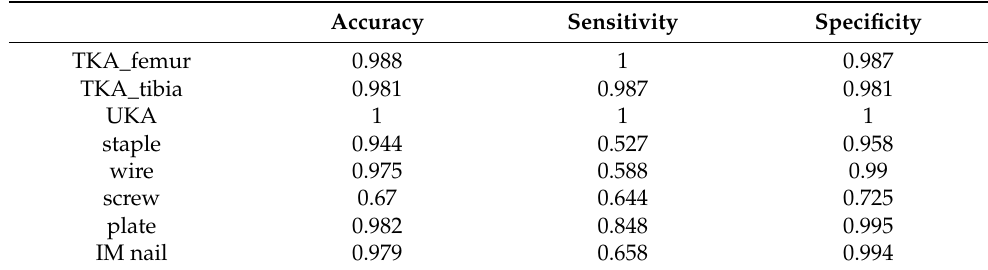
Table 4. Evaluation metrics on the external test